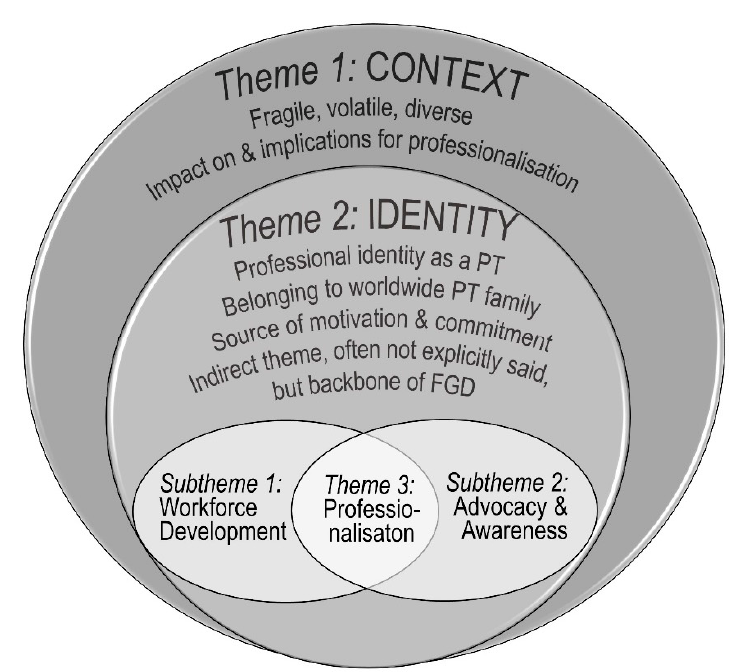
Figure 1. Themes. The main themes are illustrated in the circles. The themes ‘Context’ and ‘Professional Identity’ frame, define and influence the sector-specific theme ‘Professionalisation’, which comprises the sub-themes ‘Workforce Development’ and ‘Advocacy and Awareness Raising’. Figure 2 zooms further into these two subthemes. PT = physiotherapist/physiotherapy; FGD = focus group discussions.